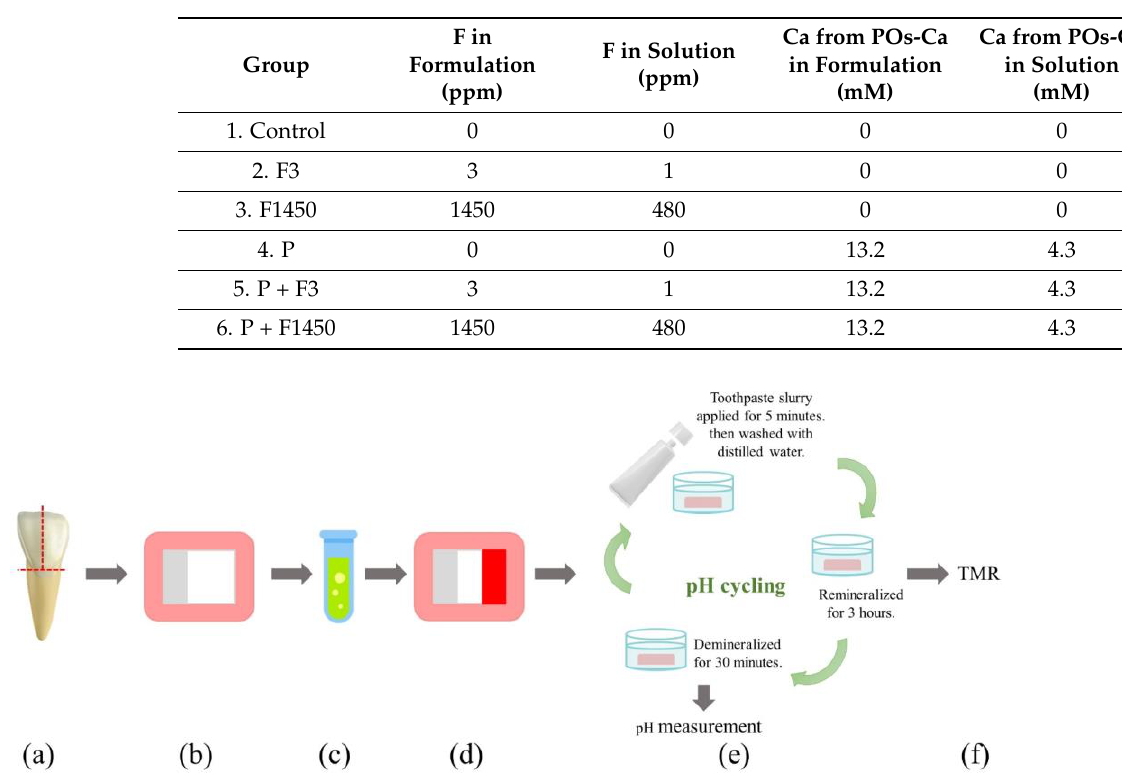
Table 1. Composition of the toothpaste used in the study.